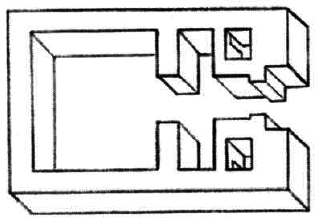
Figure 12. Isometric plan of the Rujm al-Kursi temple (Hübner 2015, p. 194, abb. 3).